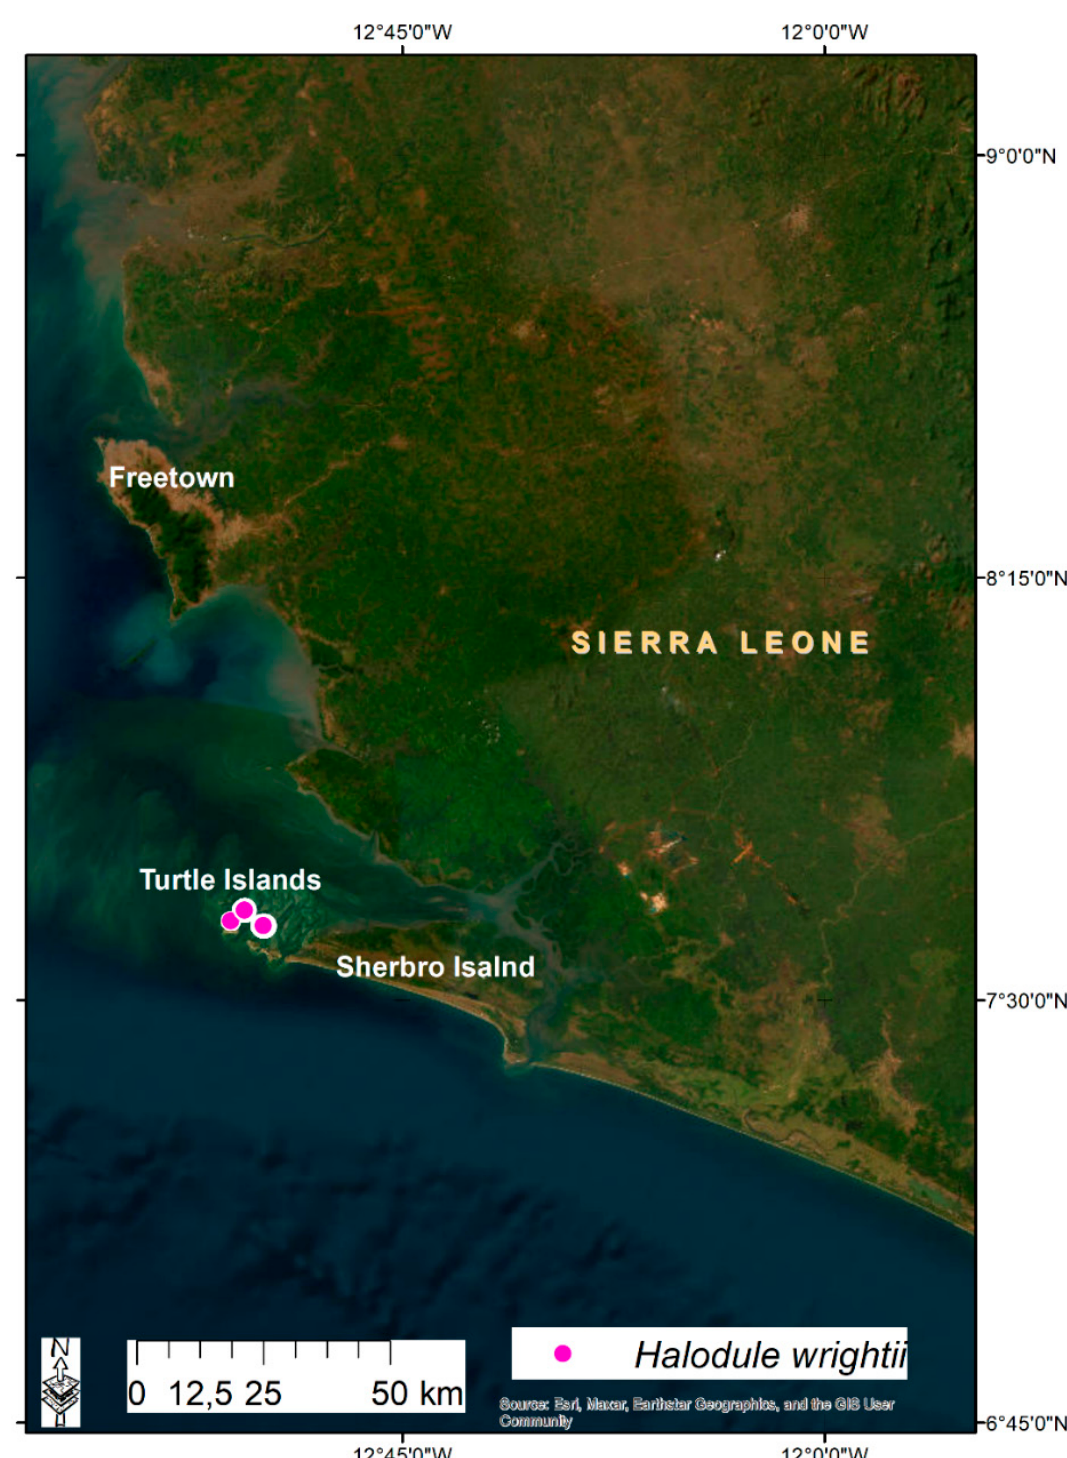
Figure 8. Seagrass distribution in Sierra Leone.